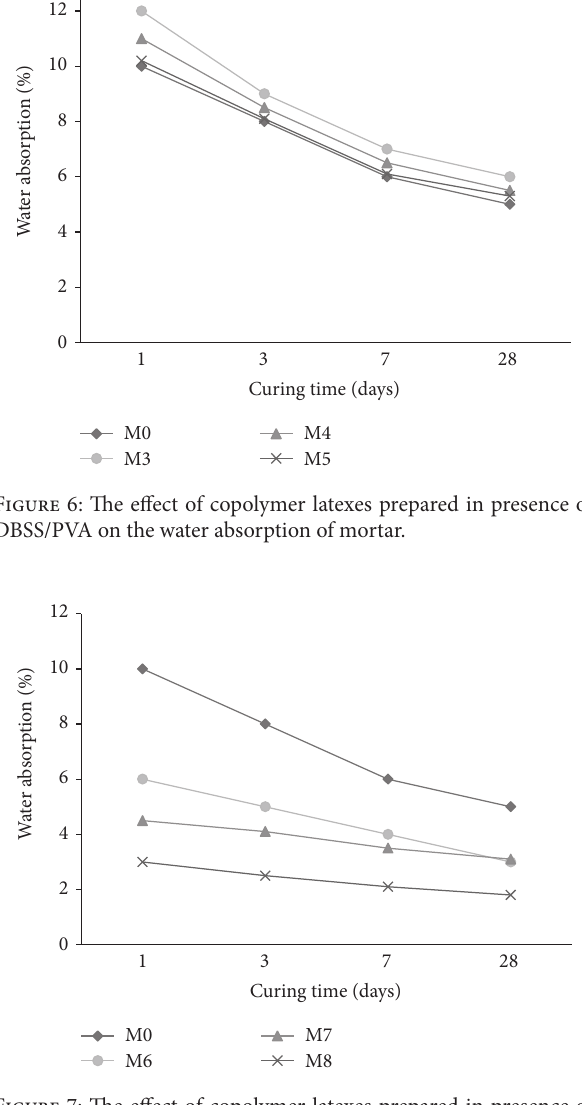
Figure 7: The effect of copolymer latexes prepared in presence of DBSS/POE on the water absorption of mortar.